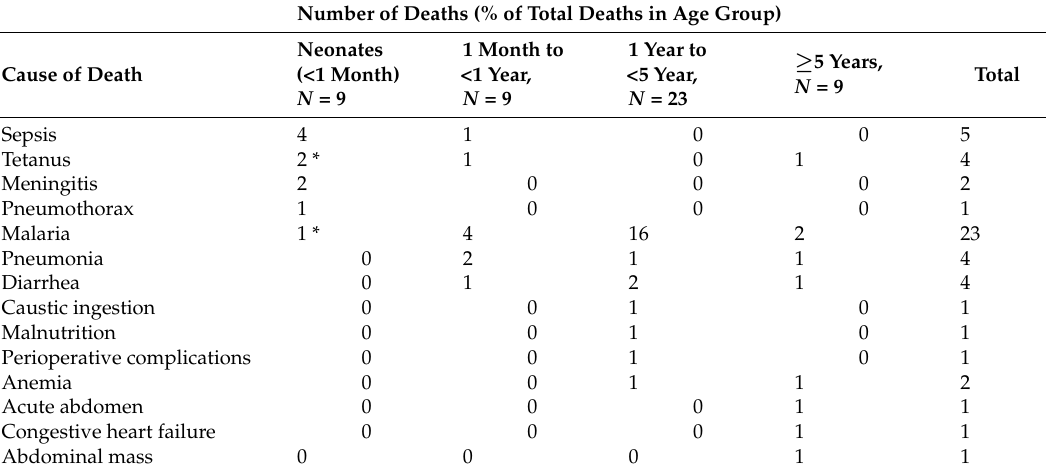
Table 1. Causes of pediatric death stratified by age